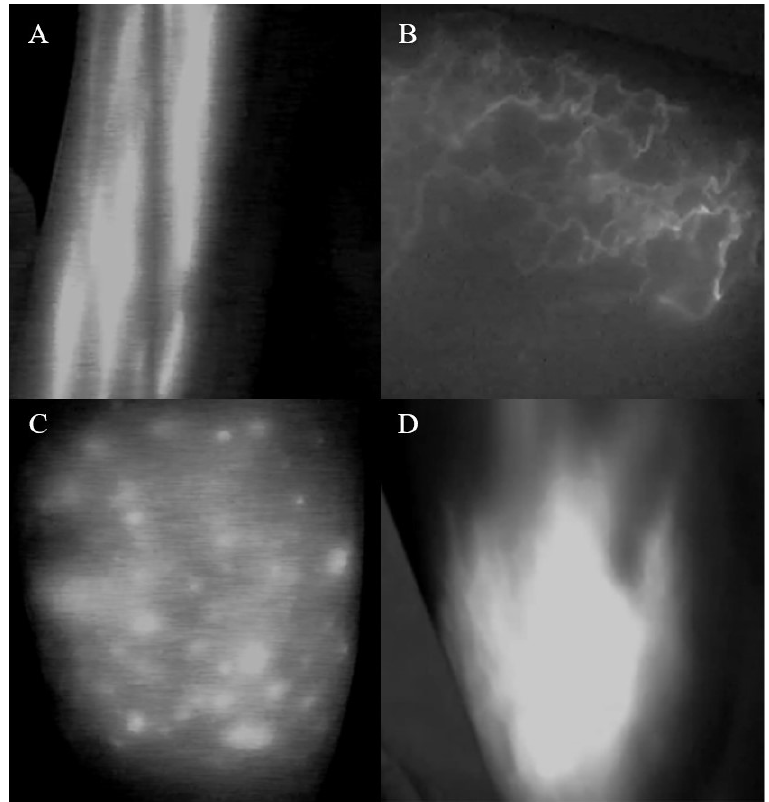
Figure 2. Normal pattern and dermal backflow patterns of ICG lymphography (( A ): linear pattern; ( B ): splash pattern; ( C ): stardust pattern; ( D ) diffuse pattern) (ICG, indocyanine